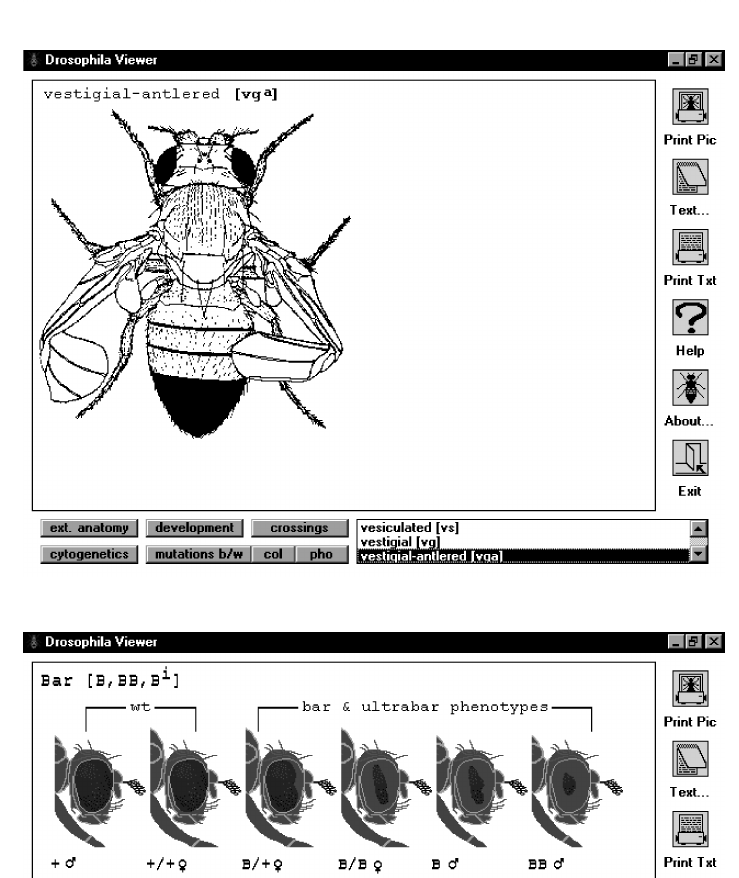
Figure 7 - Female-type intersex with a ventral view detail shown on the left. Original drawing by Edith M. Wallace. The picture was selected by clicking the item in the option list shown on the right after pressing the command button “cytogenetics.”